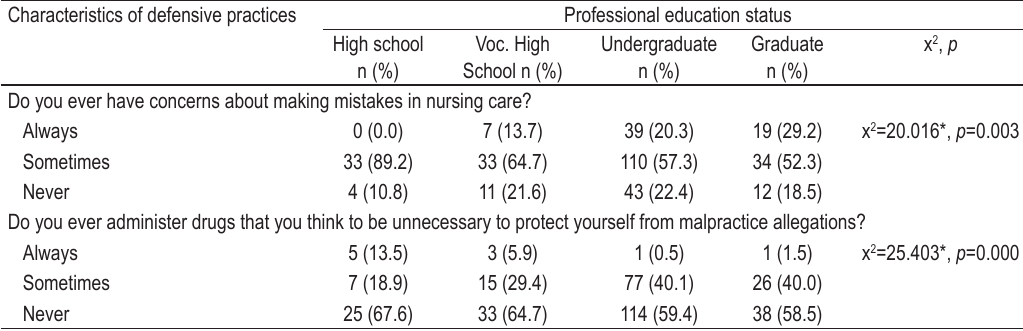
TABLE 3. Nurses’ characteristics of defensive practice in regard to their professional education status (n=345) Characteristics of defensive practices